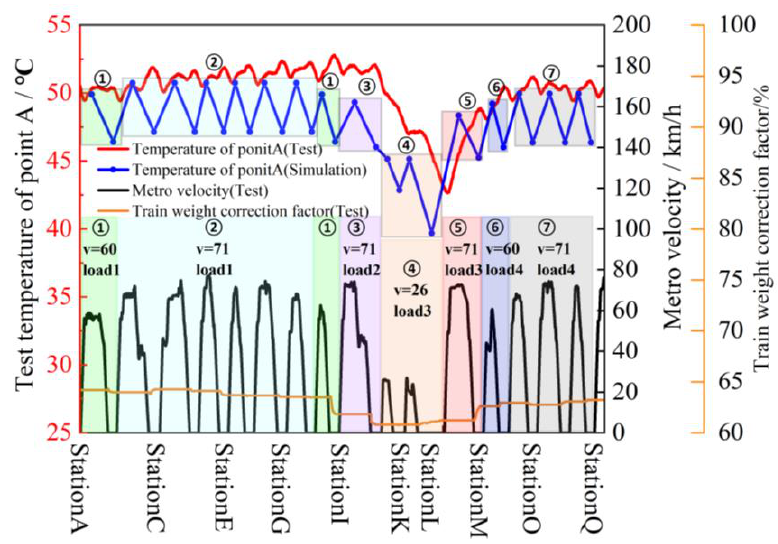
Figure 26. Comparison of simulation and experimental results.